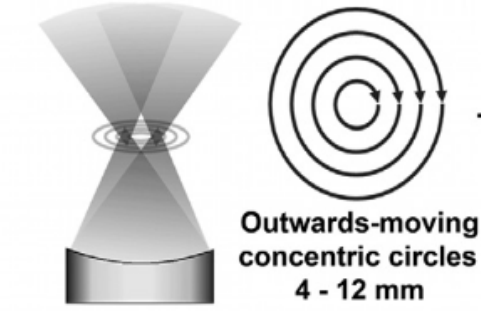
Figure 18. Path of electronically steered HIFU transducer focal point for Ablation with the Sonalleve System, enabling more homogeneous energy delivery